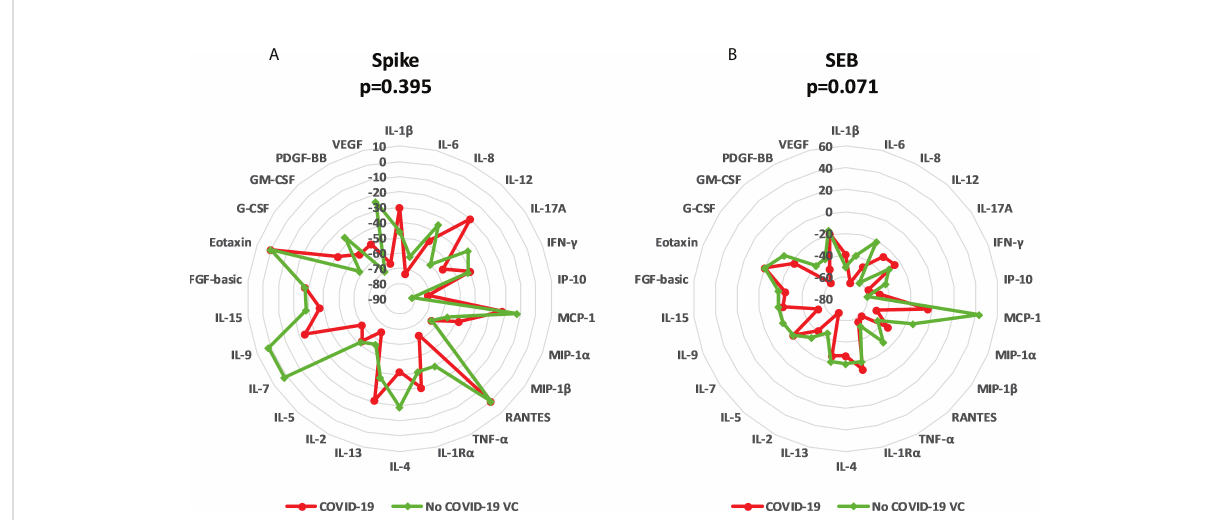
FIGURE 6 Modulation of immune factors after IL-10 treatment for each analyte in COVID-19 patients and NO COVID-19-Vaccinated Controls (NO COVID-19-VC) of study population “ B ” . (A) Spike stimulation; (B) SEB stimulation. Data are reported as the median of the percentage of variation for each analyte. Mann Whitney Test was applied to compare the overall median of variations of each stimulation between COVID-19 patients and NO COVID-19-VCs.